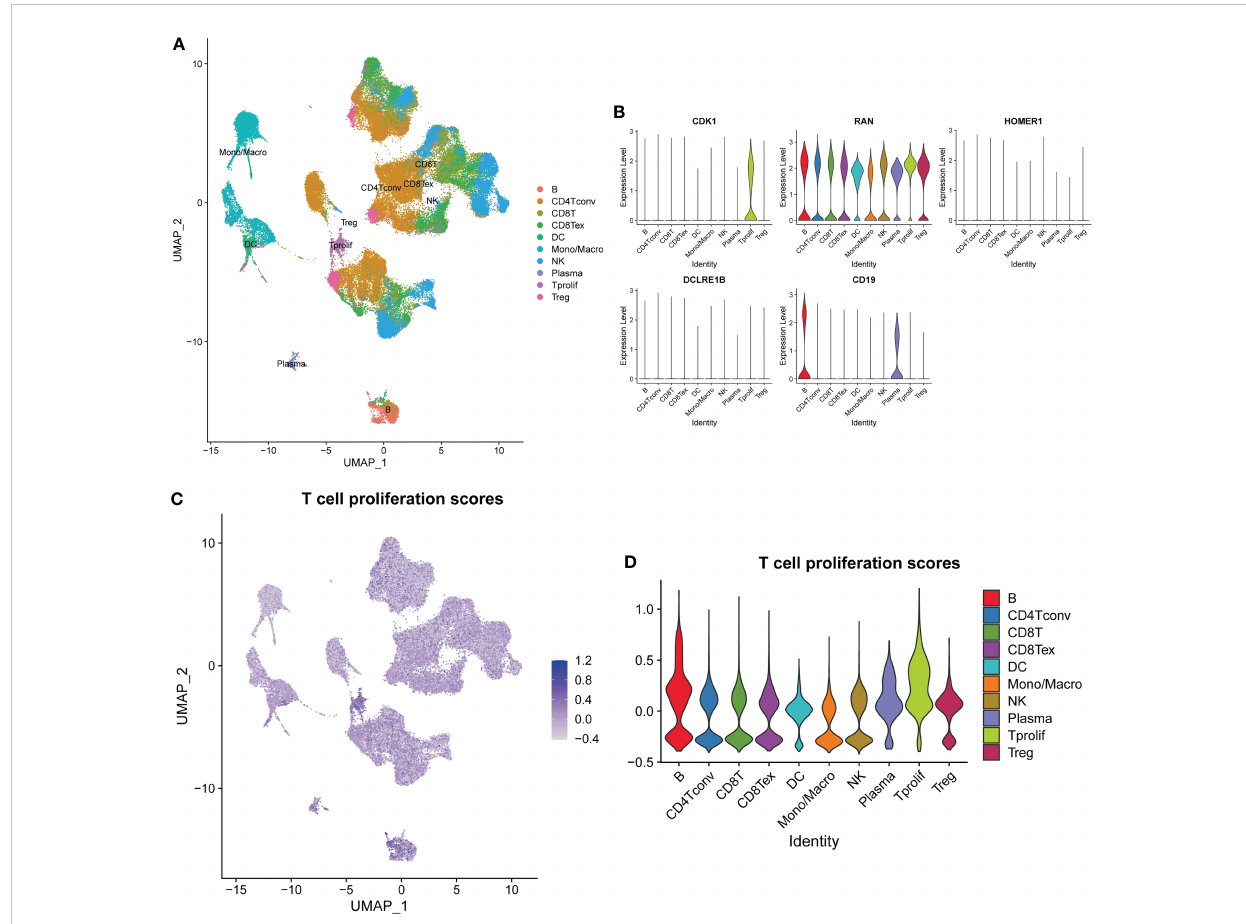
FIGURE 4 Overview of single cells from lung adenocarcinoma tissues and normal tissues. (A) Distributions of ten types of immune cell in tissues. (B) Expression pro fi les of 5 prognostic T cell proliferation-related regulator genes in the ten major types of immune cells. (C) The deeper the color, the higher the T cell proliferation score. (D) T cell proliferation scores in the ten major types of immune